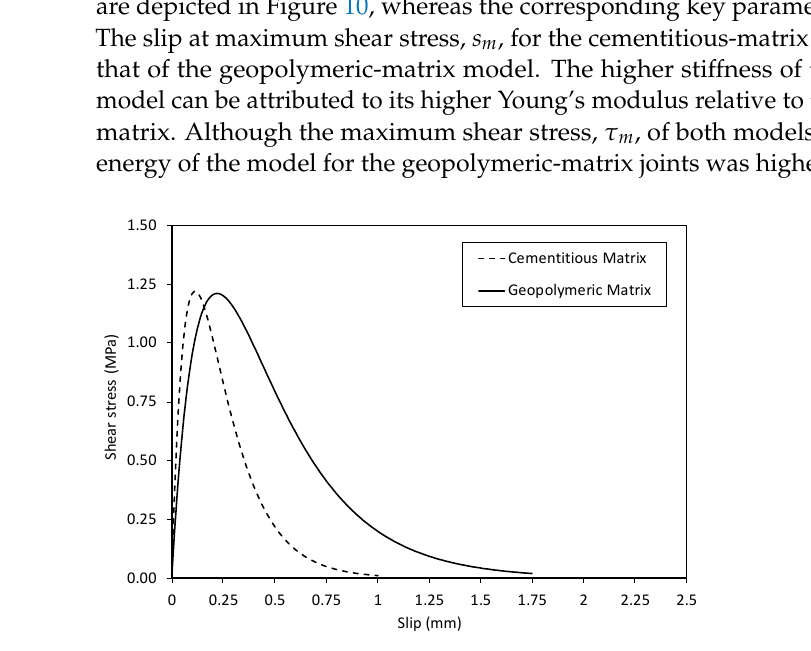
Figure 9. Shear stress-slip relationships for the tested specimens with l b > l eff : ( a ) Cementitious-matrix specimens, ( b ) Geo- polymeric-matrix specimens. Table 4. Parameters of the bond-slip models.